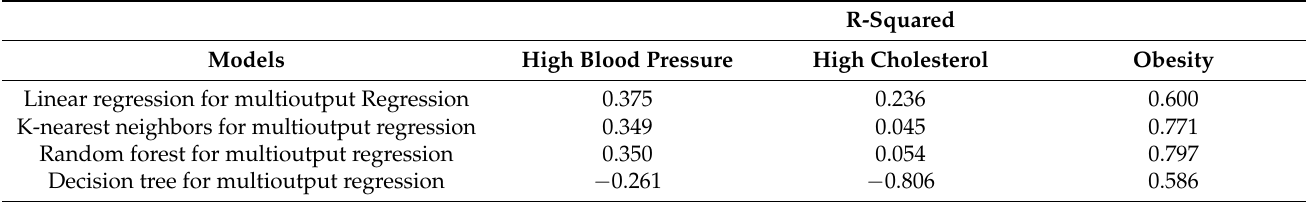
Table 4. R-Squared values of the k-nearest neighbors, random forest, and decision tree for multioutput regression.